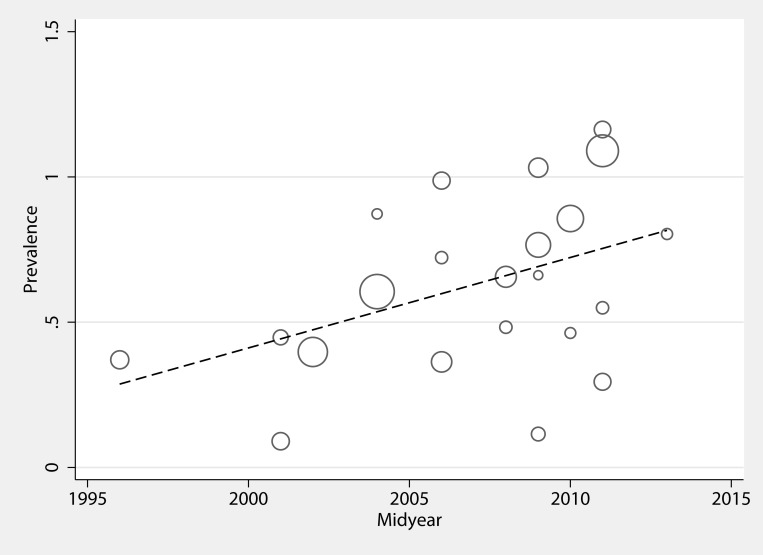
Time trend of ESBL-PE laboratory-confirmed bloodstream infections (1996–2013) depicting annual increase of 3.2%.Circles illustrate the estimates from each study, sized proportionately to the precision of each estimate. The fitted regression line is represented by study midyear.